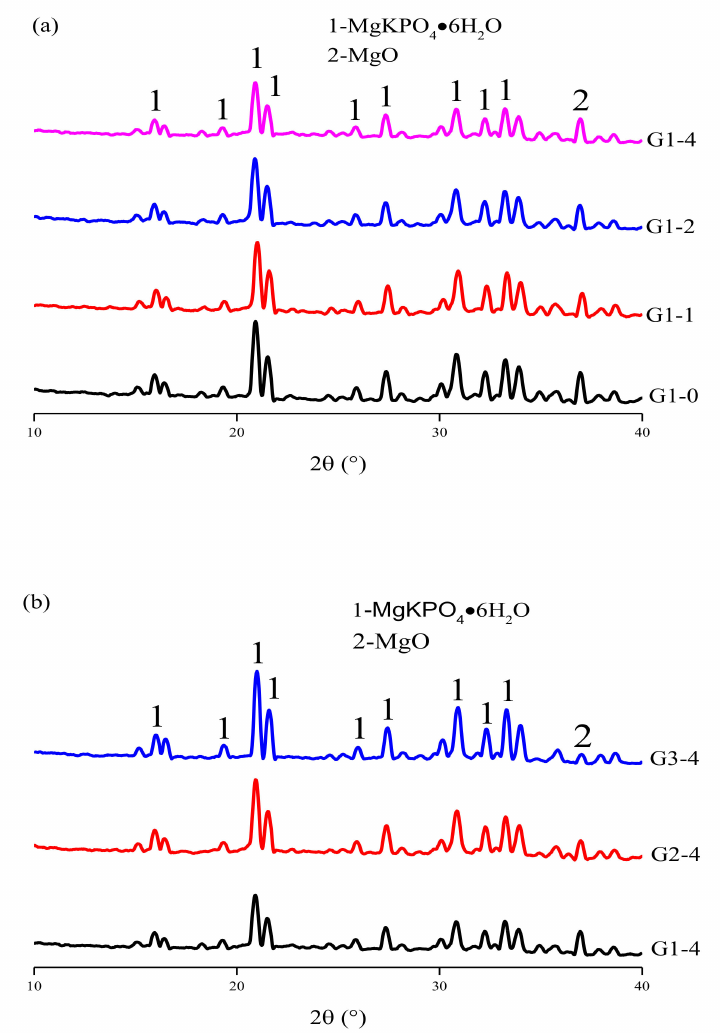
Figure 6. XRD patterns of the samples hydrated for 28 d: ( a ) samples with different glass powder concentrations and an M/P ratio of 3:1, and ( b ) samples with different M/P ratios and a glass powder concentration of 40